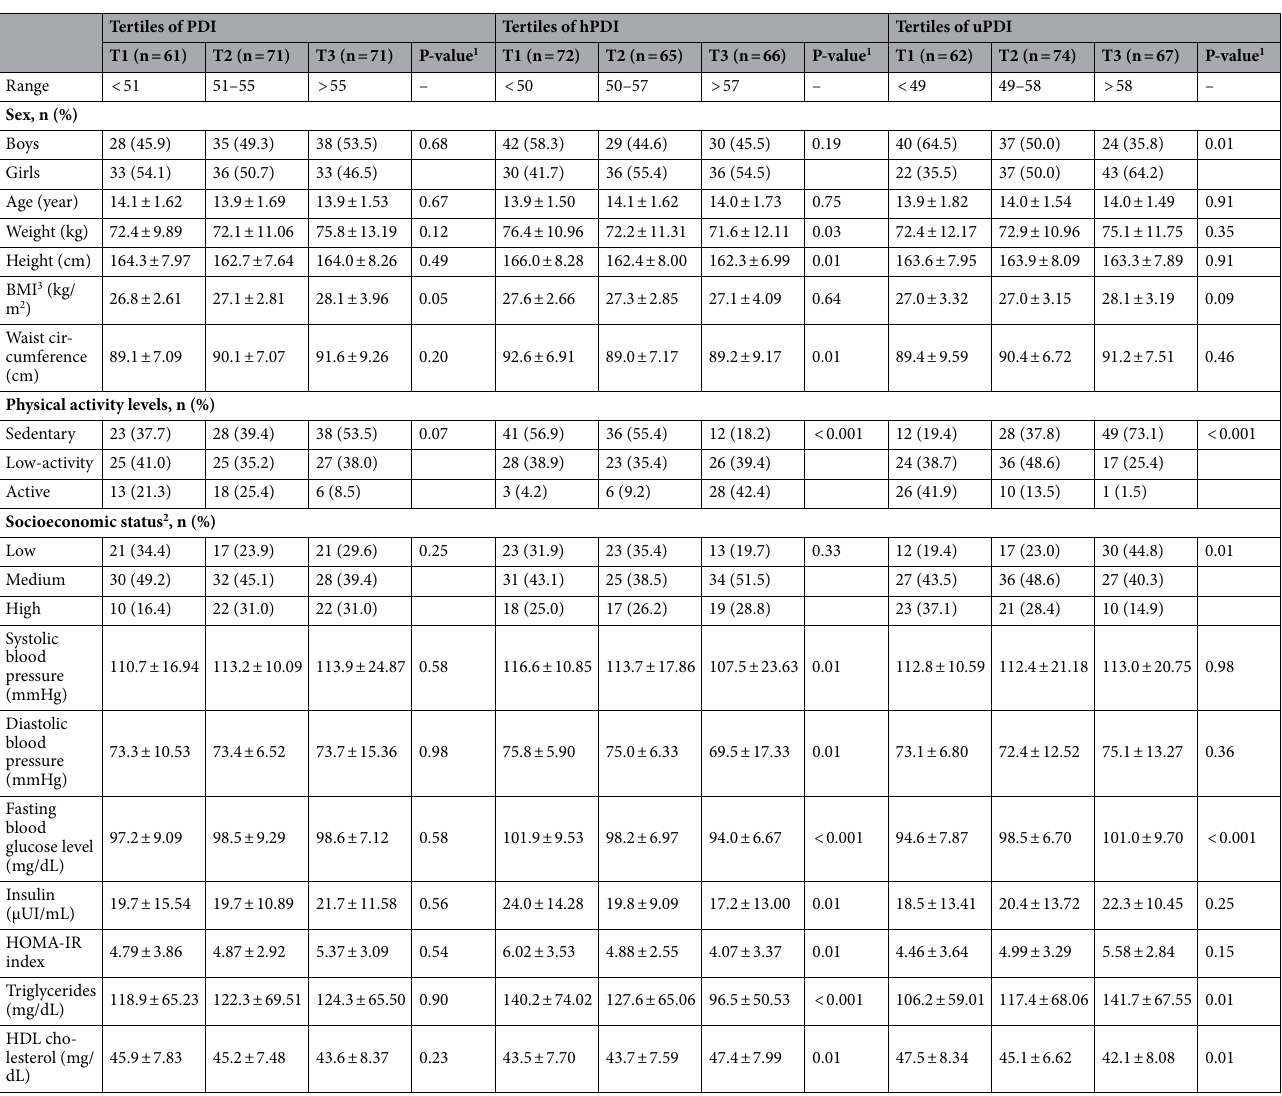
Table 1. General characteristics and cardiometabolic factors of study participants across tertiles of PDI, hPDI and uPDI. Values are Mean ± SD; unless indicated. Abbreviations: BMI: Body Mass Index; HOMA-IR: Homeostasis Model Assessment Insulin Resistance; HDL-c: high-density lipoprotein cholesterol. 1 P-value for one-way ANOVA test and χ 2 test for quantitative and categorical variables, respectively. 2 Socioeconomic status (SES) score was evaluated based on parental education level, parental job, family size, having car in the family, having computer/laptop, having personal room and having travel by using demographic